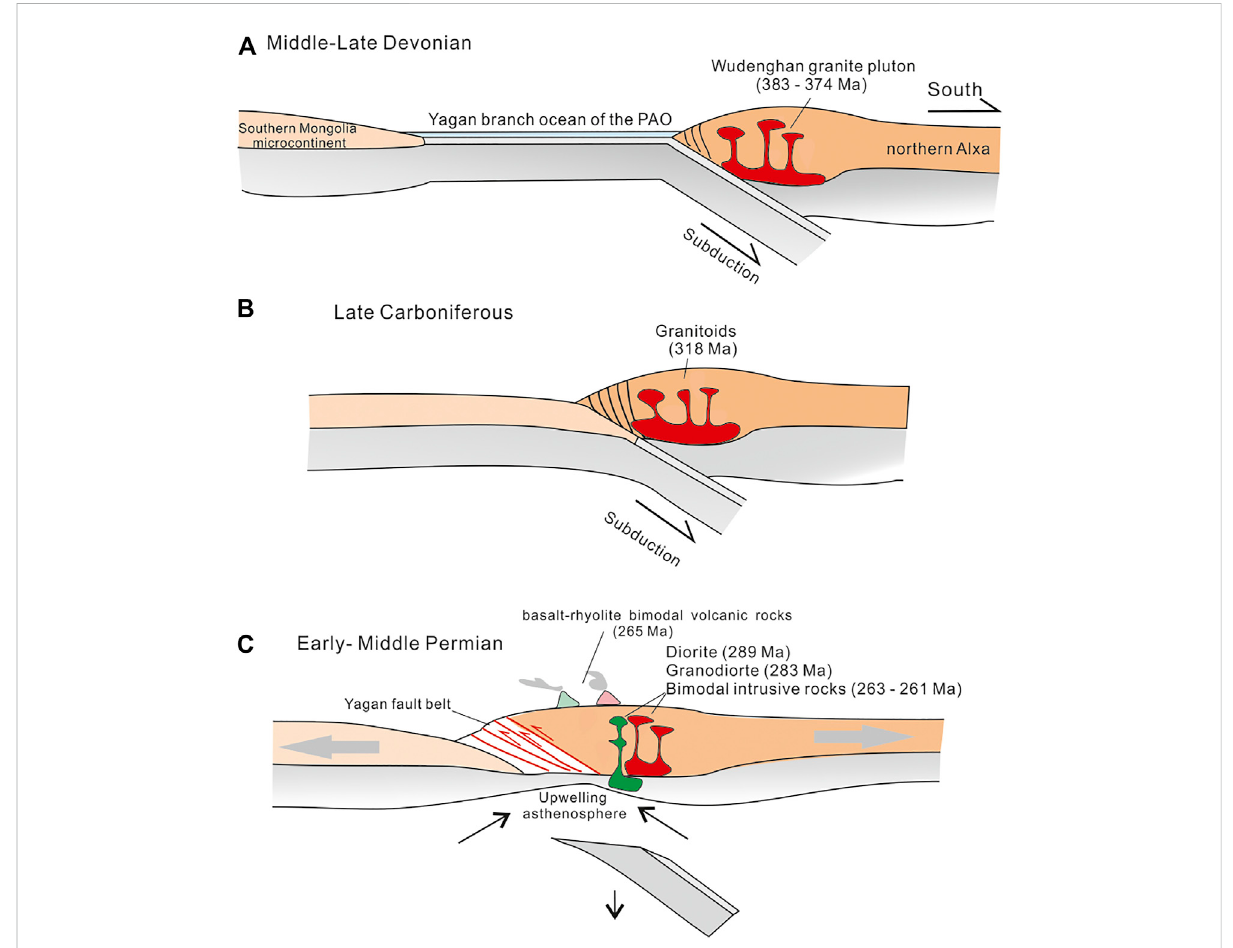
FIGURE 12 Late Paleozoic tectonic evolution model in the northern Alxa (Data: Zhang et al., 2017; Li, 2019; Xie et al., 2020; Zhao et al.,